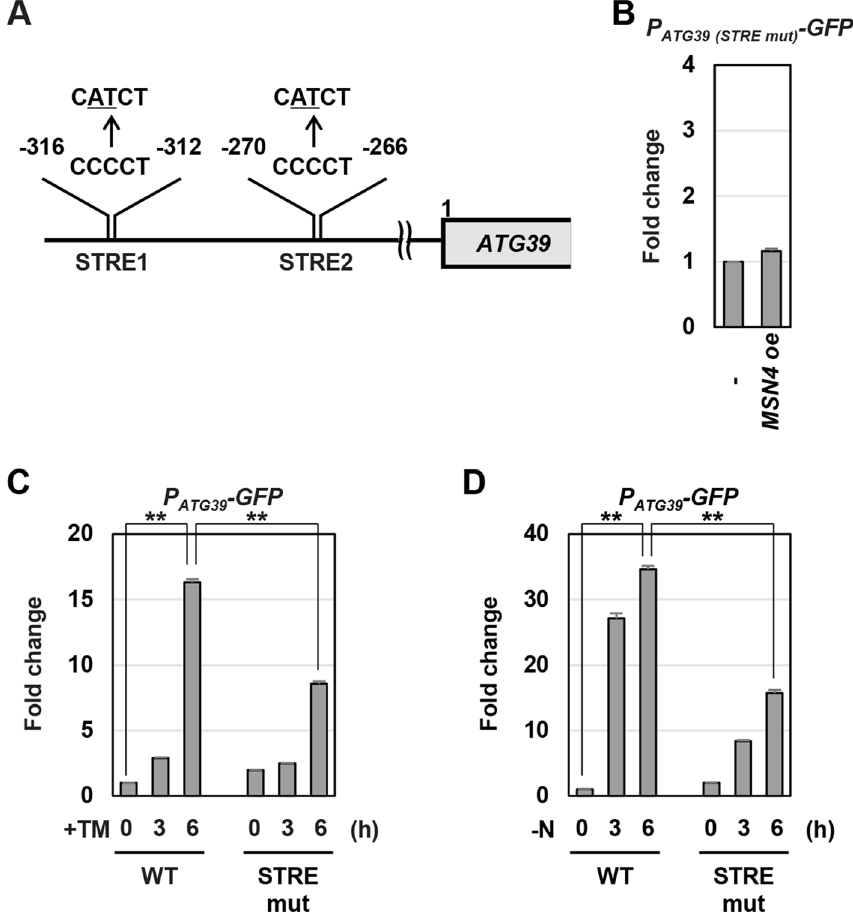
Figure 3. Msn2/4 positively regulate ATG39 promoter activity through the STRE elements. ( A ) Two putative STRE elements in ATG39 promoter region. ( B ) Effects of MSN4 overexpression on expression of the P ATG39 - GFP reporter mutated in putative STRE elements. Wild-type (WT) strains harboring the P ATG39 -GFP reporter mutated in putative STRE elements and the plasmids with or without the MSN4 gene were grown at 25 °C until exponential phase, and then harvested. The GFP mRNA levels were quantified by qRT-PCR analysis, and relative mRNA levels were calculated using ACT1 mRNA. The values are plotted as the fold change from cells harboring the plasmids without the MSN4 gene. The data show mean ± SEM (n = 4). NS, not statistically significant ( P > 0.05), as determined by Student’s t -test. ( C , D ) Effects of mutations in putative STRE elements on ATG39 upregulation induced by ER stress and nitrogen starvation. Wild-type (WT) cells harboring wild- type or mutated P ATG39 -GFP reporters were grown at 25 °C until exponential phase and treated with 3 μg/ml tunicamycin (TM) (C) or incubated under nitrogen-starved conditions ( D ) for the indicated time. The GFP mRNA levels were quantified by qRT-PCR analysis, and relative mRNA levels were calculated using ACT1 mRNA. The values are plotted as the fold change from wild-type cells harboring the integration which expresses GFP under the control of wild-type ATG39 promoter at the time of TM addition or nitrogen removal. The data show mean ± SEM (n = 3). ** P < 0.01 as determined by Student’s t